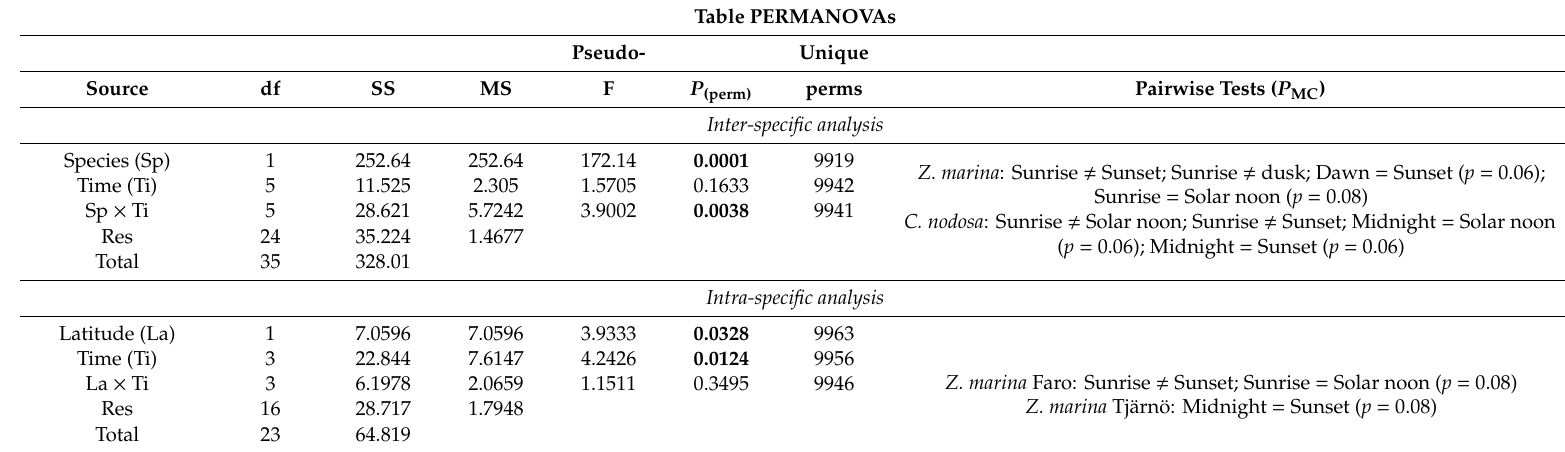
df: degree of freedom, SS: sum of squares, MS: mean squares, Pseudo-F: pseudo-F